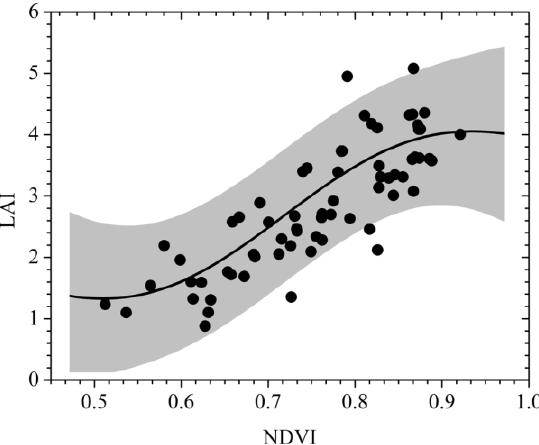
Figure 2. Regression result of the training dataset using GPR. The shaded area represents the pointwise mean plus and minus twice the standard deviation for each NDVI value (corresponding to the 95% confidence region).